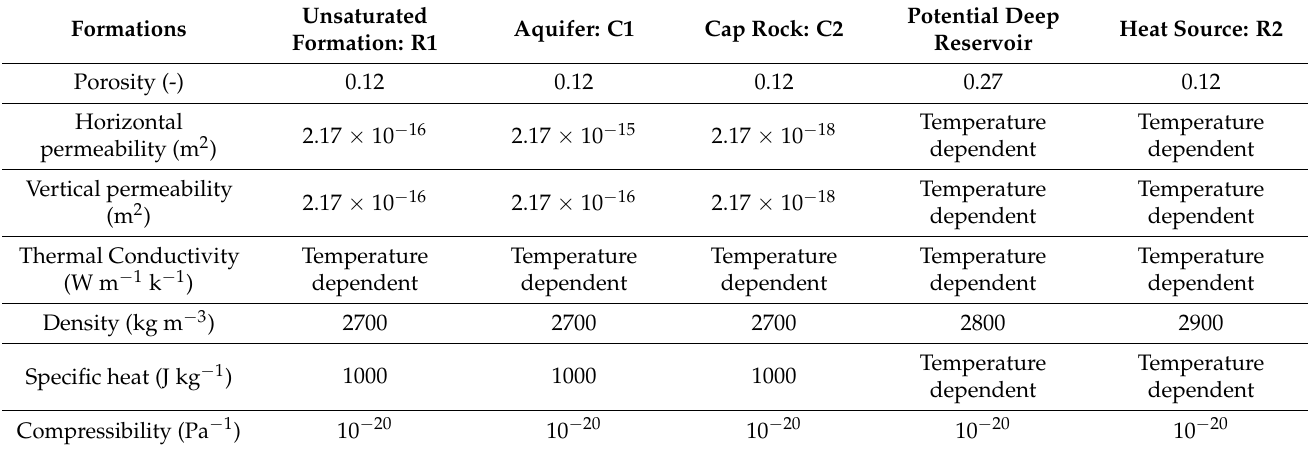
Table 1. Hydraulic and thermal properties for simulation of the base case